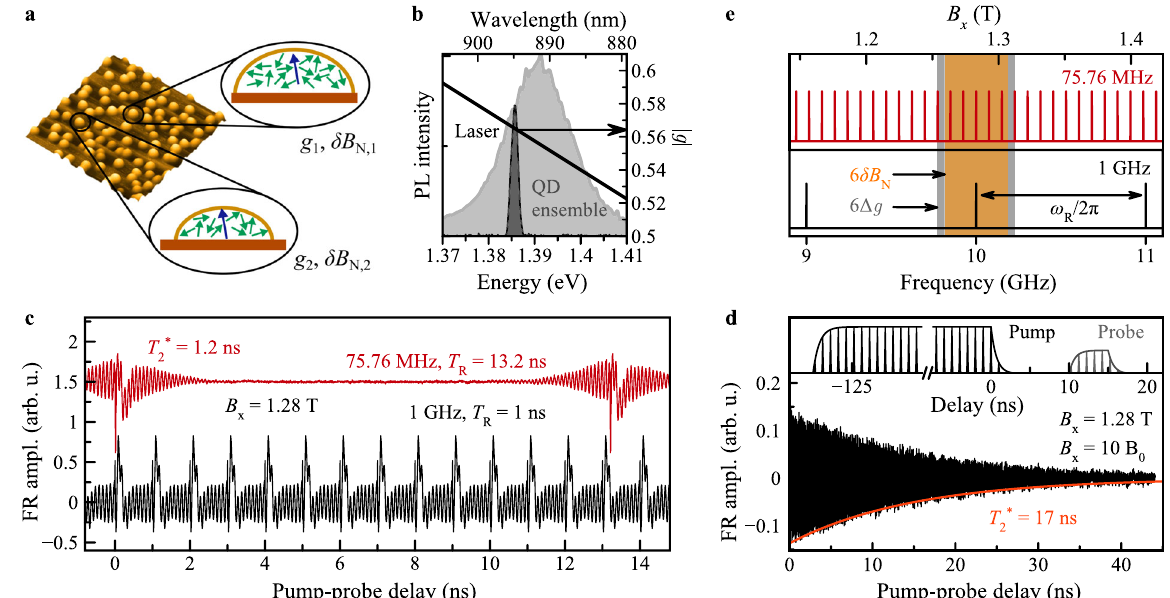
Fig. 1 Dependence of spin dephasing time T (cid:1) on laser repetition frequency. a Atomic force microscope of the (In,Ga)As/GaAs QD ensemble 2 with a QD density of 10 10 cm − 2 . Sketches indicate the nuclear spins (green arrows) interacting with a single electron (blue arrow). The QDs differ in size as well as in g -factor value. b Photoluminescence (PL) spectrum of the (In,Ga)As/GaAs QD ensemble (light gray) and spectrum of the picosecond laser emission, shown by the dark gray shaded pro fi le. The black line gives the dispersion of the absolute electron g factor. c Time-resolved Faraday rotation for laser repetition frequencies of 75.76 MHz (red) and 1 GHz (black). d Extended pump-probe signal with ¼ 17 ns. The inset shows the sequences of the applied pump and probe pulse bunches. For panels c and d containing experimental data T (cid:1) 2 the following conditions hold: T = 5.3 K, E Pu/Pr = 1.3867 eV. Used laser powers: for 75.76 MHz P Pu = 600 W/cm 2 , P Pr = 6 W/cm 2 ; for 1 GHz P Pu = 260 W/cm 2 , P Pr = 8 W/cm 2 . e Scheme of the PSC ful fi lling precession frequencies (red lines) for the 75.76 MHz laser. The orange area shows the spread of the nuclear fl uctuations in the QDs, 6 δ B N = 45 mT, and the gray shaded area gives the precession frequency range due to g -factor spread at B x = 1.28 T. The black lines below demonstrate the situation for the 1 GHz laser excitation. Here, the mode separation is increased to 128